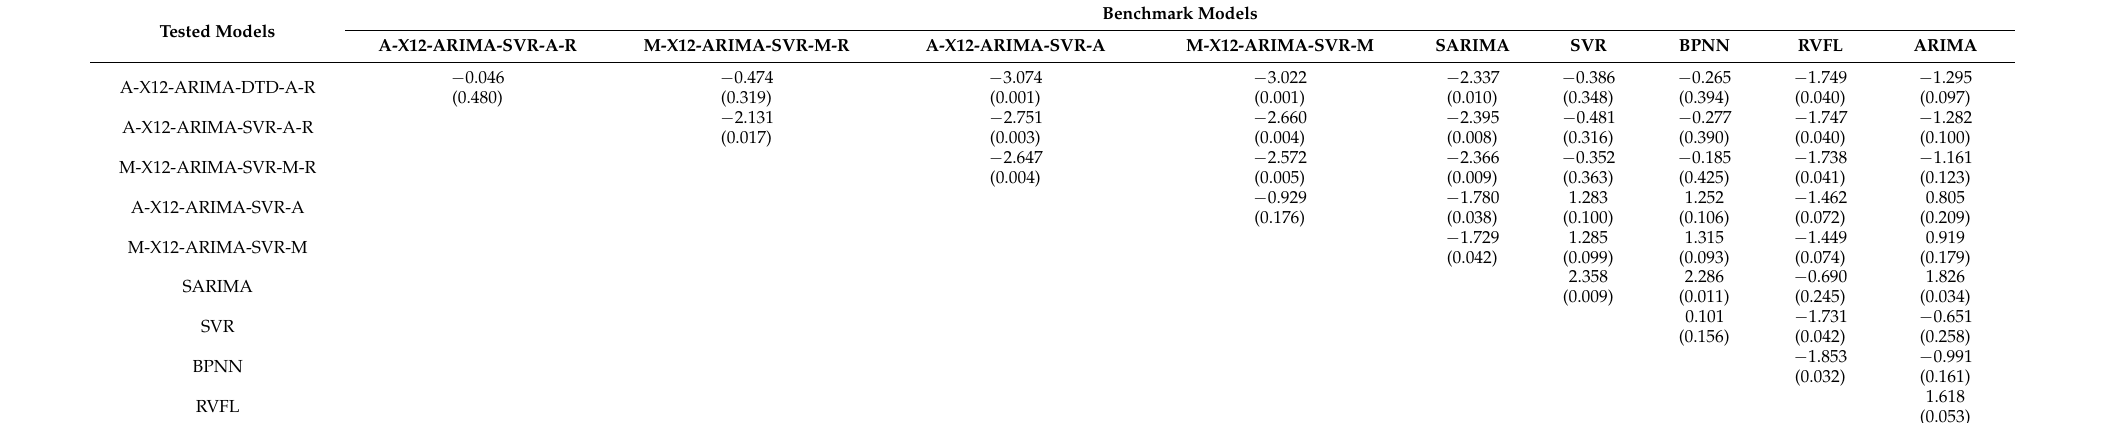
Table 16. DM test results across different models for gasoline consumption data in